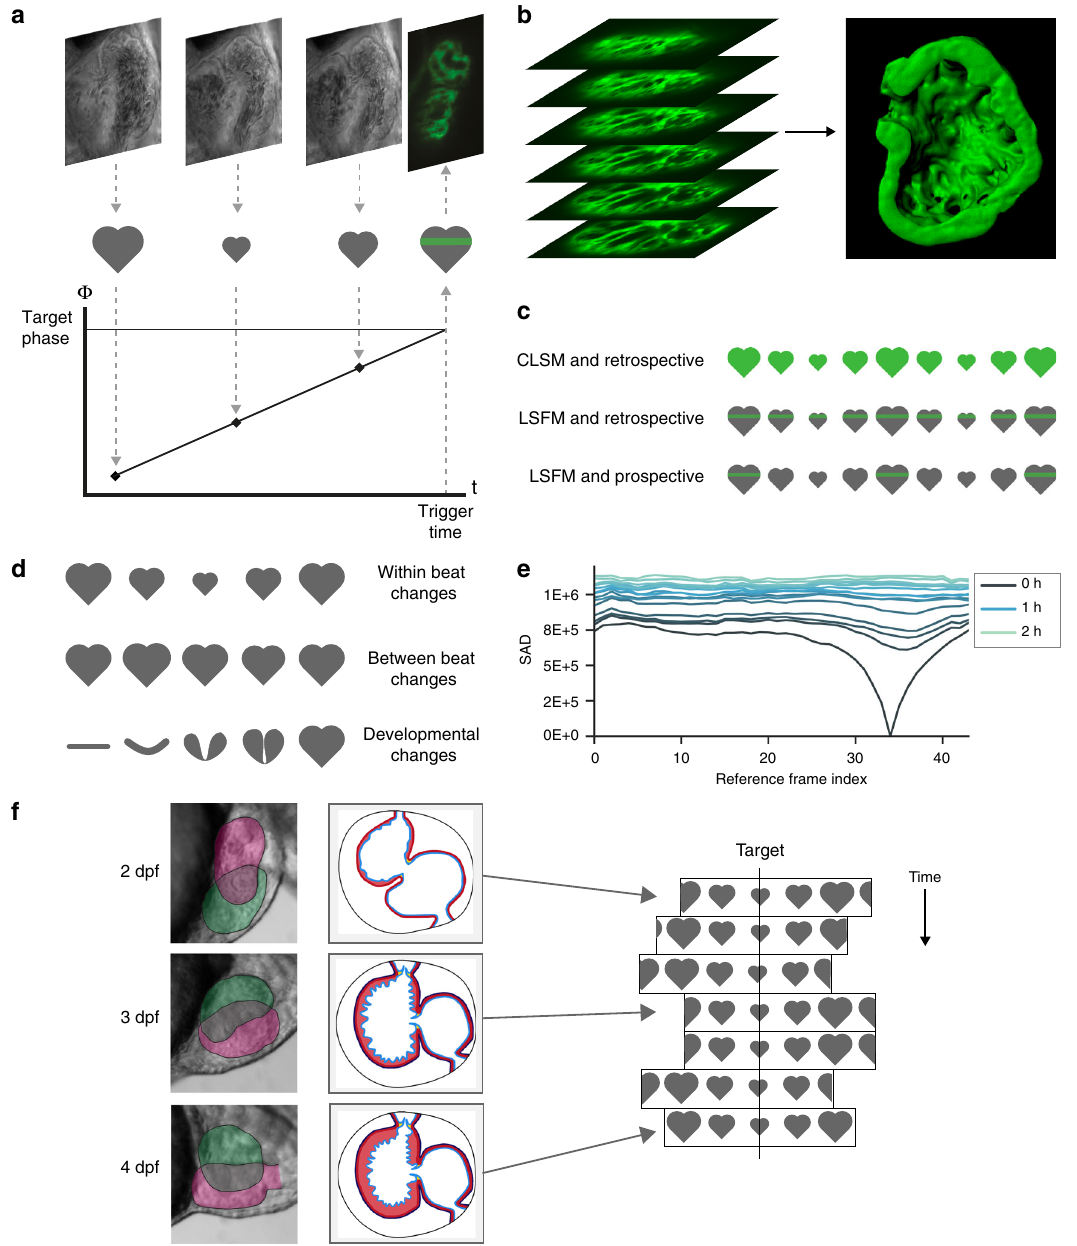
Fig. 1 Developmental changes in cardiac morphology prevent day-long time-lapse imaging with existing algorithms. a In prospective optical gating, bright fi eld images (greyscale) are acquired and analysed in real time to assign a phase (temporal position in the cardiac cycle) to each frame. Forward prediction is then used to accurately trigger acquisition of one synchronised fl uorescence image (green) at a user-de fi ned target phase. b The sample is scanned through the light sheet to generate a synchronised 3D z -stack. c The move from confocal laser scanning microscopy (CLSM; upper) to light sheet fl uorescence microscopy (LSFM; middle) reduces phototoxic effects by several orders of magnitude by limiting excitation in space. Similarly, the move from retrospective (upper and middle) to prospective gating (lower) reduces phototoxic effects yet further by limiting excitation in time. d Prospective optical gating relies on periodic changes within heartbeats (upper) and is able to cope with small changes between heartbeats (middle). However, phase- lock cannot be maintained over developmental time scales, because the heart undergoes drastic morphological changes (lower). e These changes mean that image-based similarity metrics are unable to match new bright fi eld images against the reference heartbeat image sequence recorded at the start of the experiment. f A new “ smart microscope ” is required that can maintain phase-lock in the face of these drastic changes in cardiac morphology over the course of day-long time-lapse forward prediction in prospective gating, incorporating a different ages of fi sh. We now incorporate an automated biological understanding of heart rhythm variability. Our understanding of where in the reference image sequence the previously published prospective gating algorithms for acquiring refractory period between heartbeats is located. Since this interval individual z -stacks 10 required human fi ne-tuning of the algo- varies slightly in duration from one beat to the next, it poses a rithm parameters for different phases in the cardiac cycle, and challenge for forward prediction to anticipate the correct time to